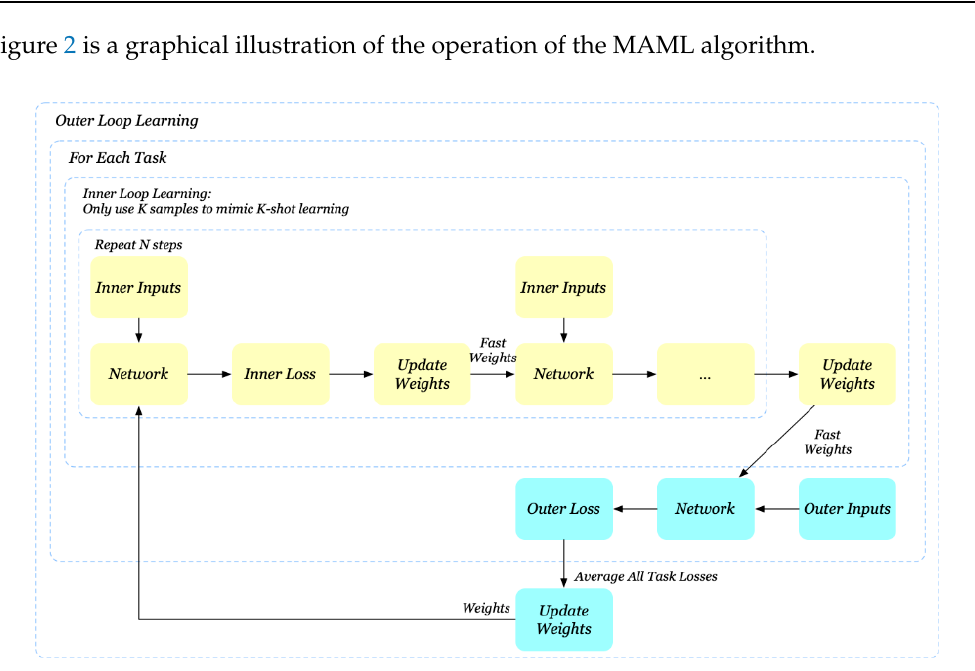
Figure 2. Graphical presentation of the MAML.